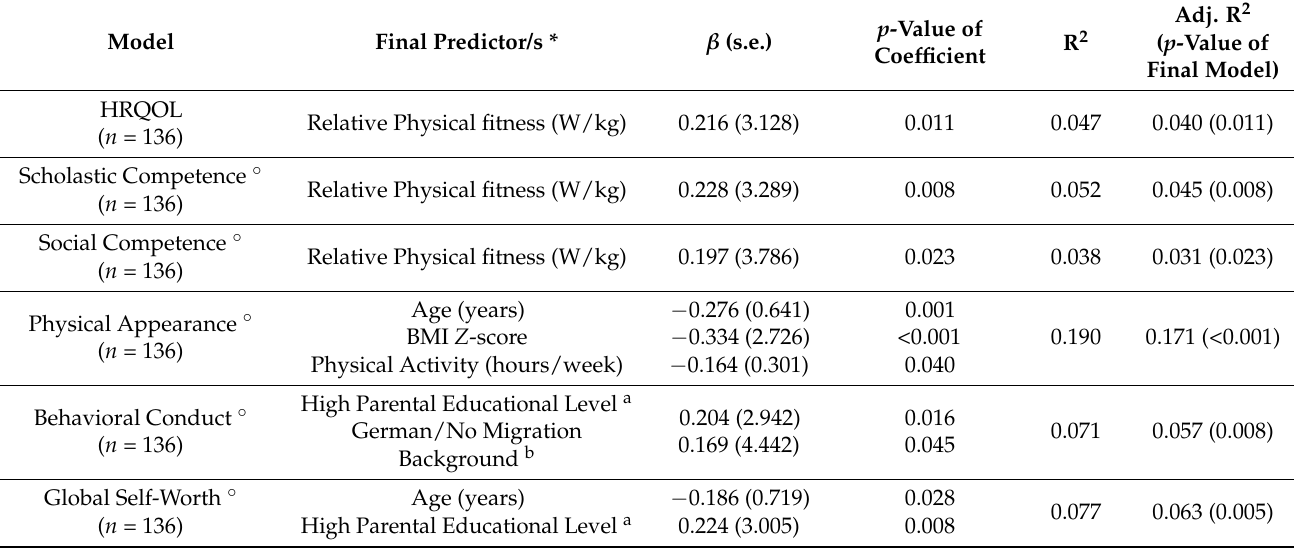
Table 2. Final Models from Backard Stepwise Multivariable Linear Regression